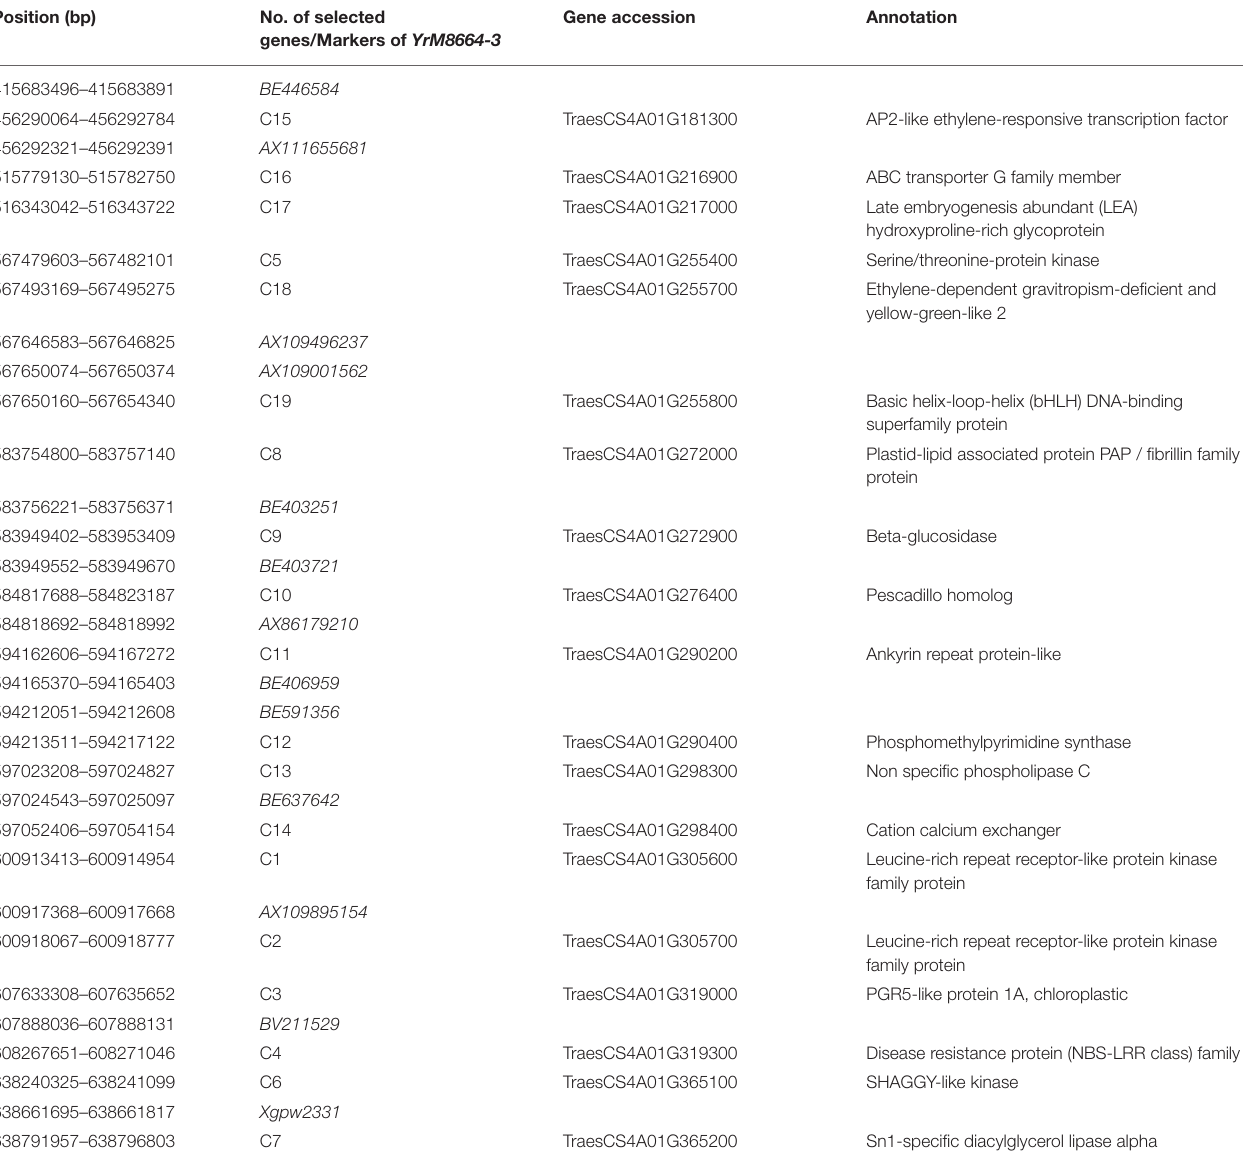
TABLE 1 | Nineteen candidate genes and markers linked to resistance gene YrM86664-3 on chromosome 4AL. Position